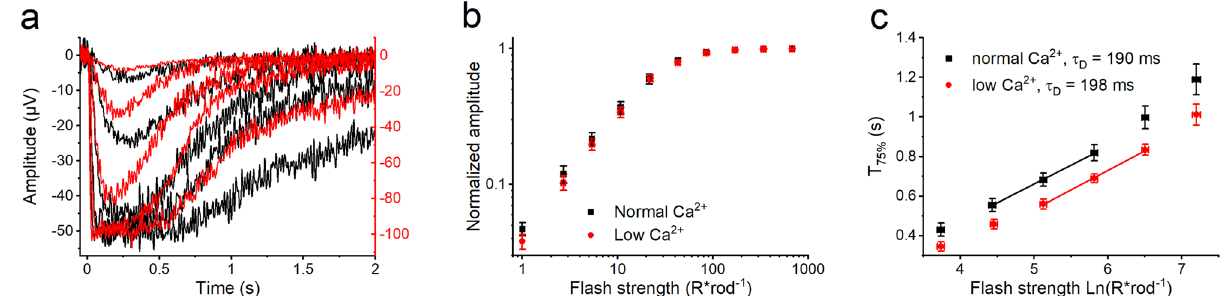
Figure 1. Effect of low Ca 2+ on mouse rod flash responses recorded with LERG-OS. ( a ) Response families first recorded in normal Ca 2+ (black traces and left y-axis) and then in low Ca 2+ solution (red traces and right y-axis). The flash strengths were 2.64, 10.5, 41.9, 167, and 664 R*rod −1 in both solutions and responses are averages from 1 to 7 repetitions. ( b ) Operation curves for rod flash responses recorded in normal Ca 2+ (black squares) and in low Ca 2+ (red circles) solution normalized with the LERG-OS saturation amplitude. Each symbol presents